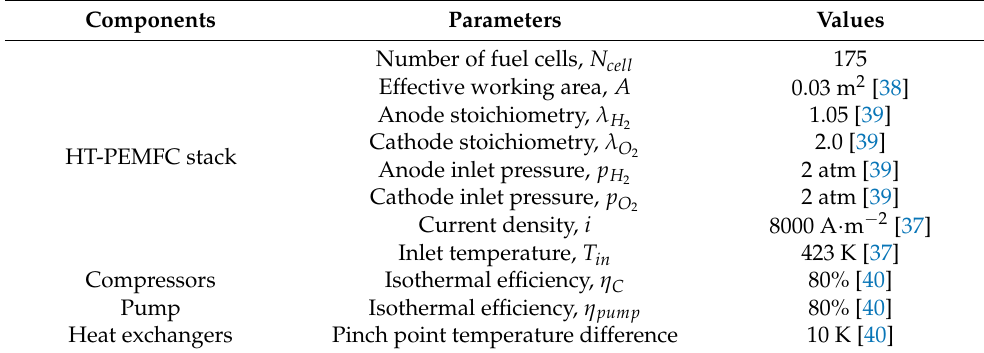
Table 1. Input parameters for system thermodynamic modeling.